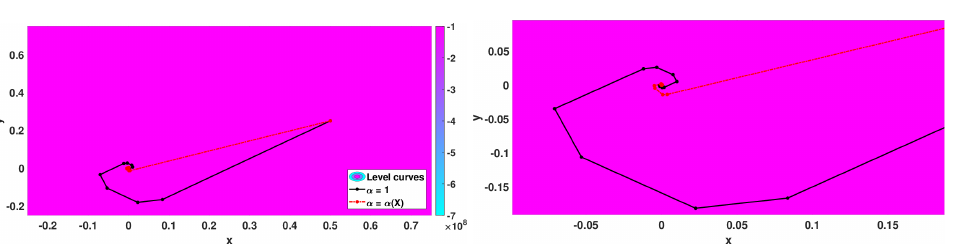
Figure 13. Iterates for f 3 ( Ψ 1 ( X )) .